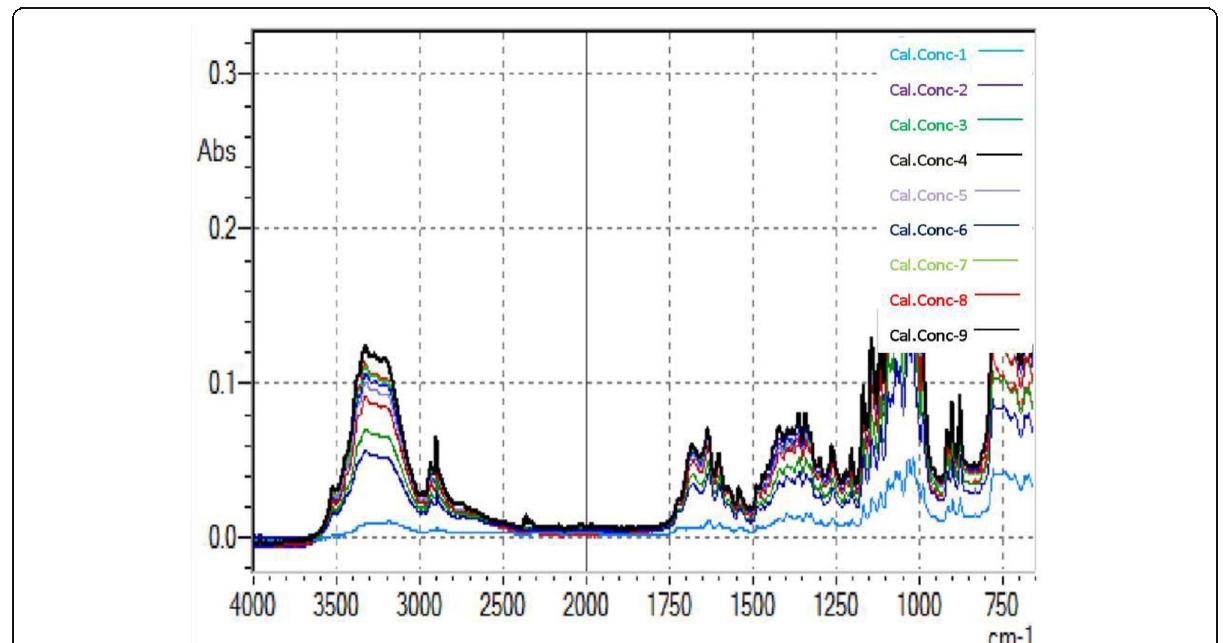
Fig. 3 Overlay scan calibration concentration of